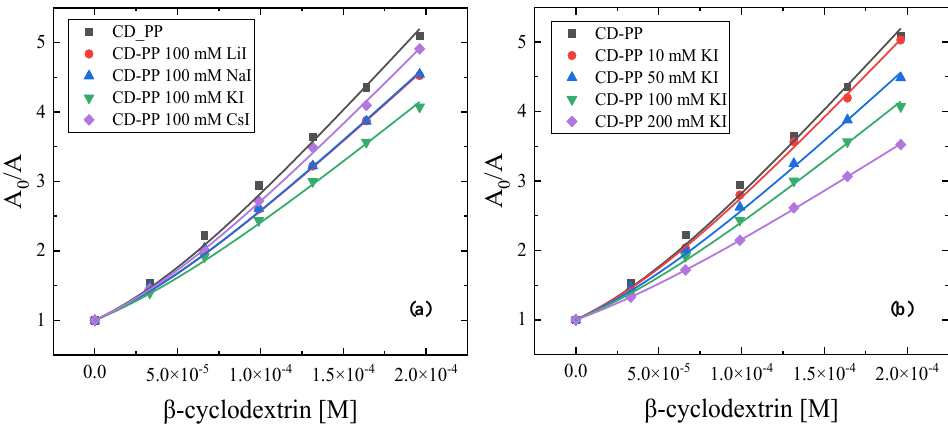
Figure 3. Concentration dependence of the ratio A 0 /A for different alkali-types (a) and salt concen- trations (b).